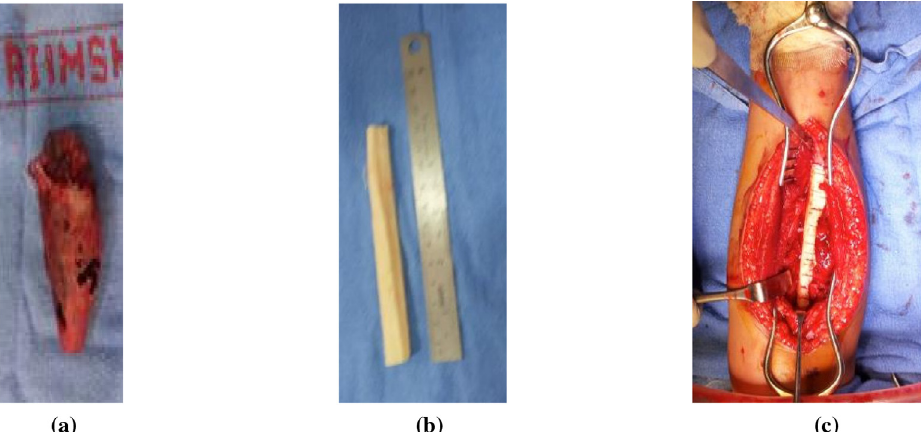
Figure 4. Intraoperative picture showing the (a) resected tumor, (b) harvested maternal fibula, and (c) maternal fibula used for reconstructing the radius.